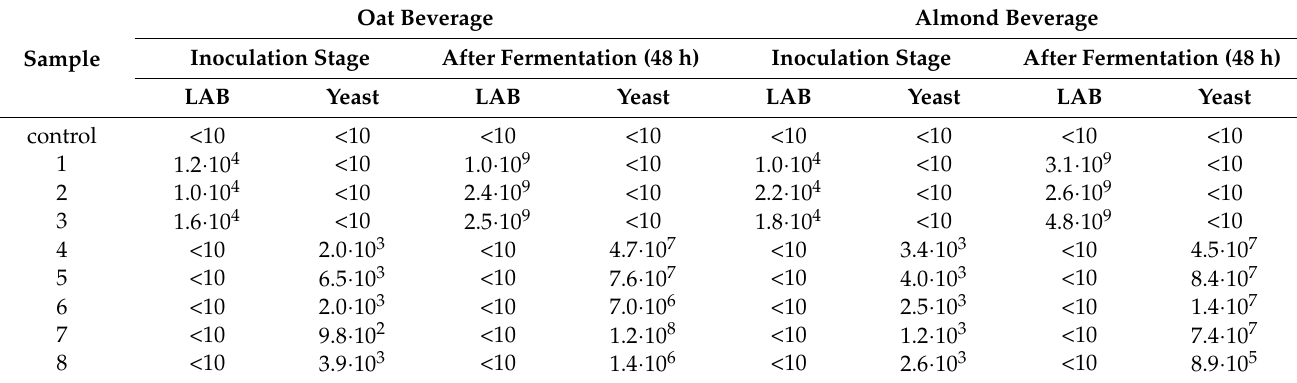
Table 1. Lactic acid bacteria (LAB) and yeast counts (CFU/mL) of plant beverages before and after